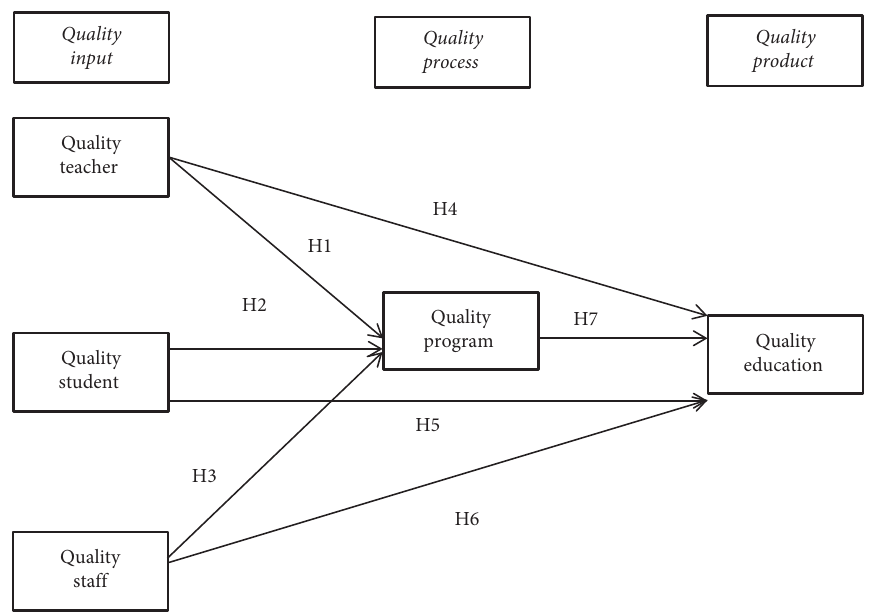
Figure 2: The 5Q model of quality